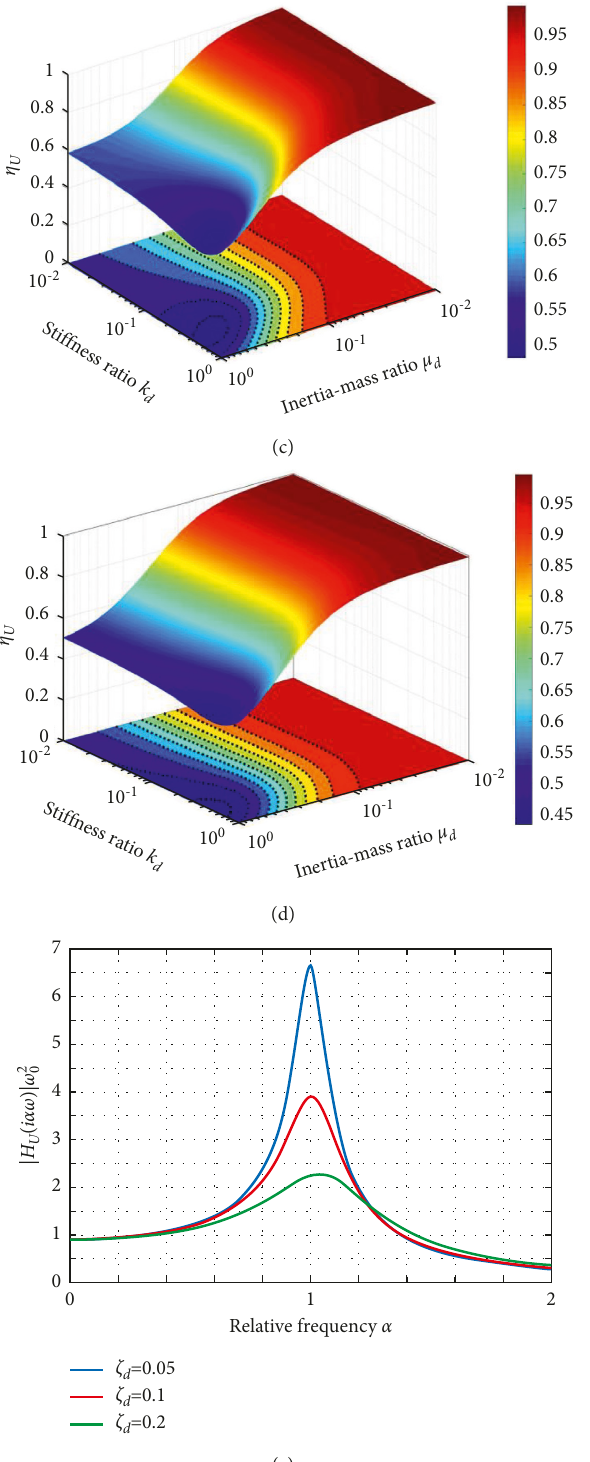
Figure 9: Mitigation ratio of displacement response: (a) changing ζ factor ( κ d � 1, ζ d �